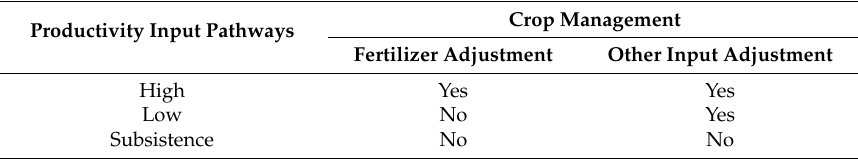
Table 1. Input assumption for the different productivity pathways. Adapted from